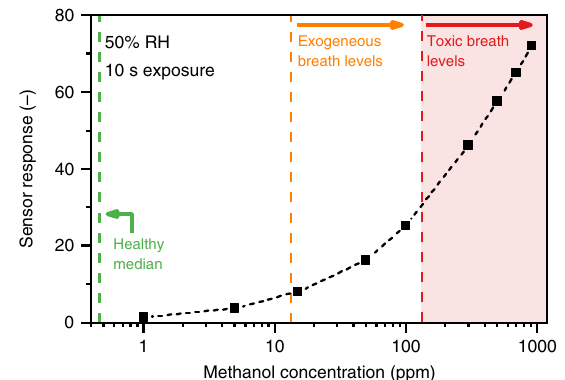
Fig. 3 Dynamic range of the detector. Response of the detector (Tenax separation column + Pd-doped SnO 2 sensor) to 1 – 918 ppm methanol concentrations (black squares and dashed line). The median methanol concentration in healthy breath 35 (green dashed line), exogeneous 36 (orange dashed line), and toxic 1 breath levels (red dashed line and shaded area) are indicated. Measurements were performed with 10 s exposure of all methanol concentrations at 50% RH and a fl ow rate of 25 mL min − 1 through the detector